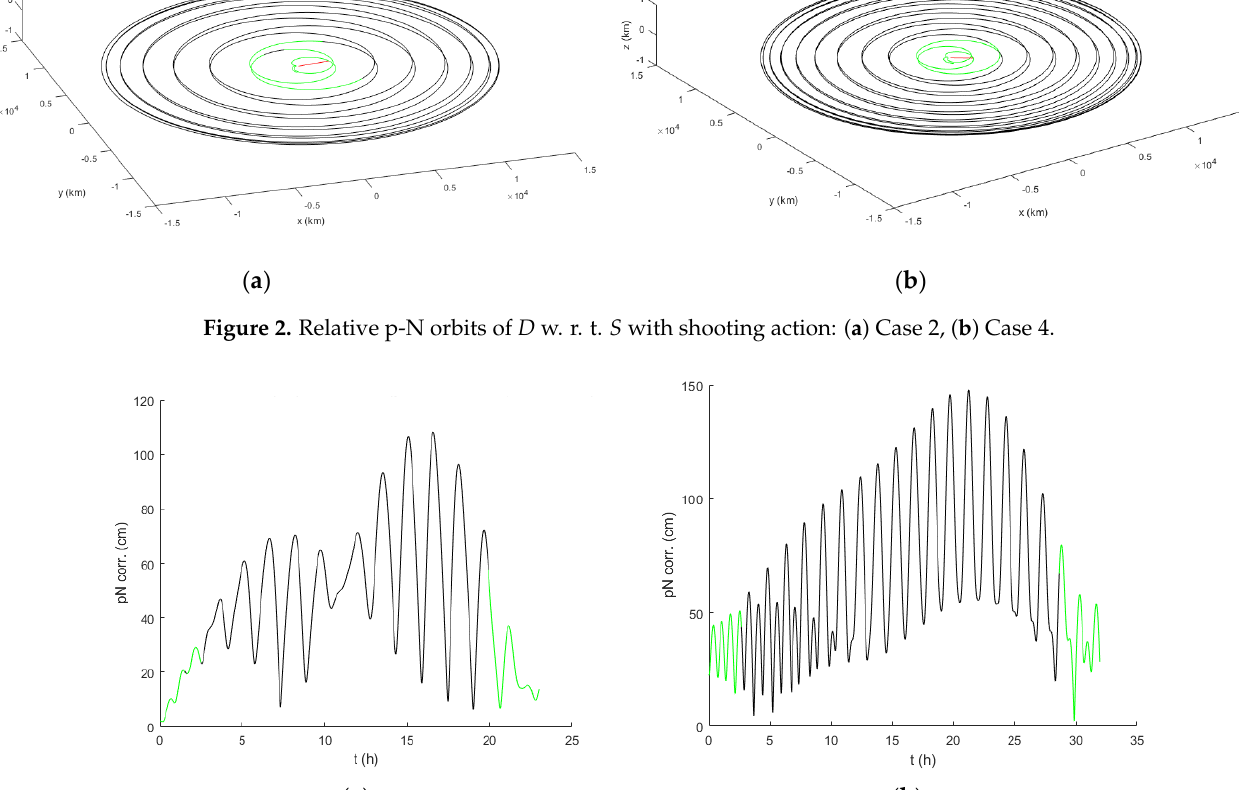
Figure 3. p-N corrections to the N locations of D w. r. t. S: ( a ) Case 2, ( b ) Case 4.